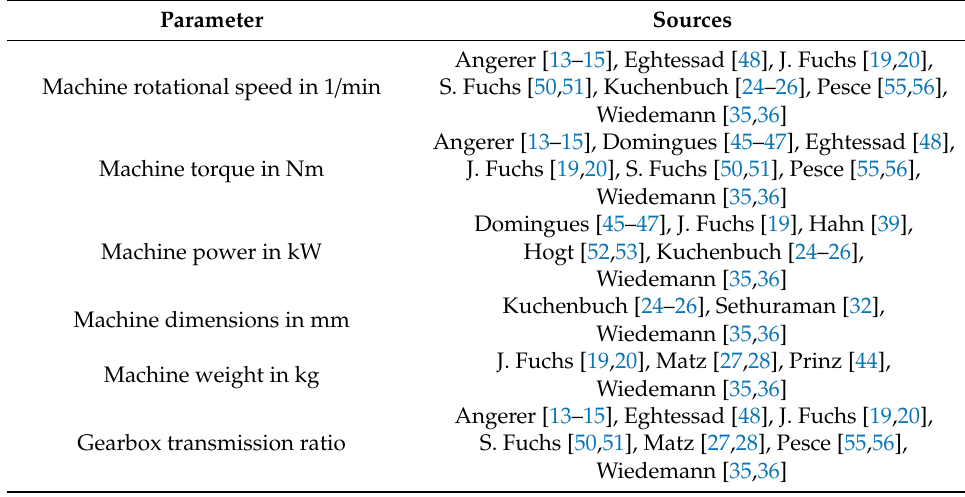
Table 6. Overview of the design parameters for the electric machine and